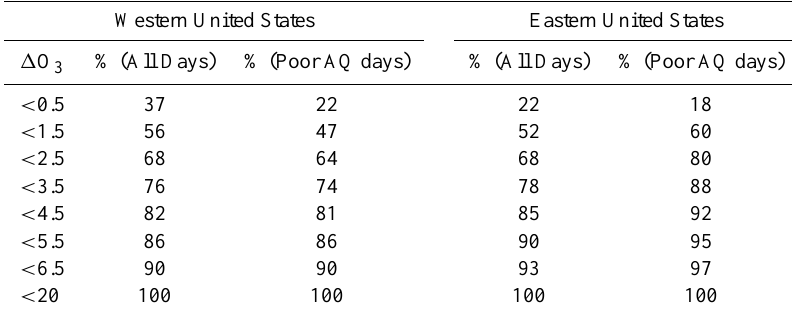
Table 1. Mean percent of CMAQ grid box-days for which lightning-NO emissions contribute less than 1 O 3 ppbv to 8h maximum ozone values over the western (longitudes west of 100 ◦ W) and eastern (longitudes east of 100 ◦ W) United States during the 1 June 2006 through 31 August 2006 time period. Only populated CMAQ grid boxes within the conterminous United States are used in the calculation. Means are shown for all grid box days and for grid box days with poor air quality. Air quality is considered poor if 8-h maximum ozone from simulation noL on that day exceeds 60ppbv in that grid box and that value is among the ten highest values at that grid box during the summer. A grid-box day refers to one grid box on one particular day.